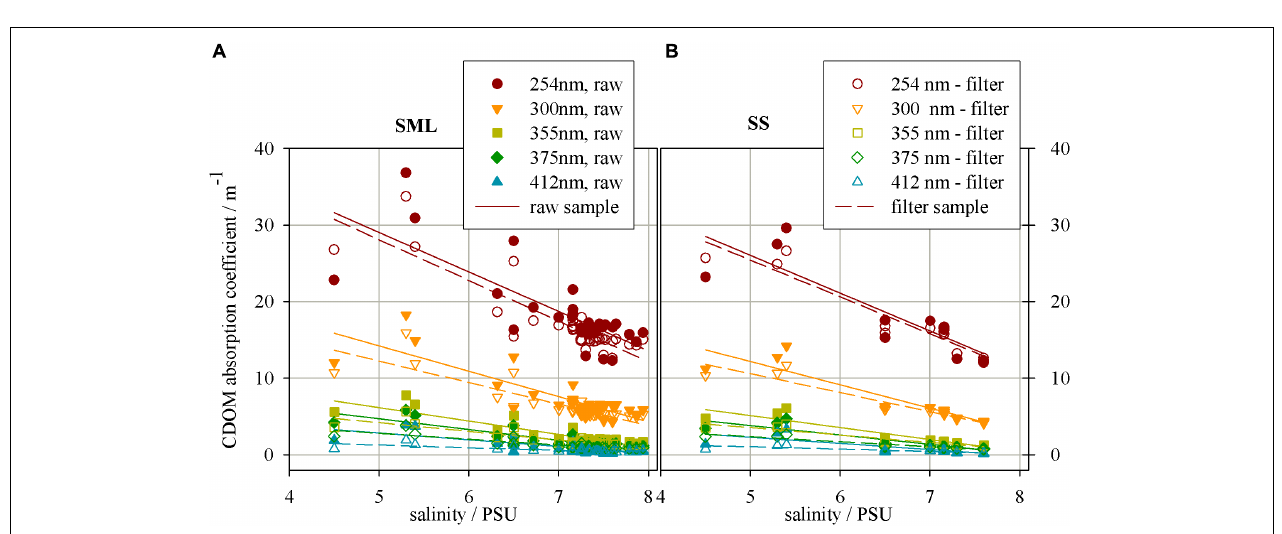
FIGURE 1 | Map of sampling stations during the cruises in June’ 2015, on R/V Akademik Ioffe (red dots) and in September and November’ 2016 on R/V Oceania (blue dots).